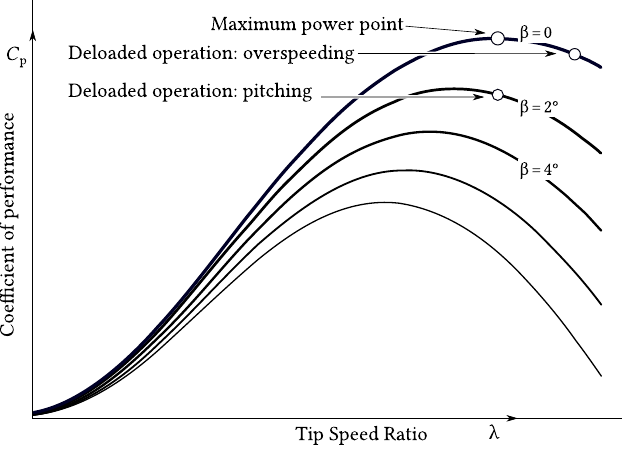
Figure 15. Deloading techniques: overspeeding and pitching.